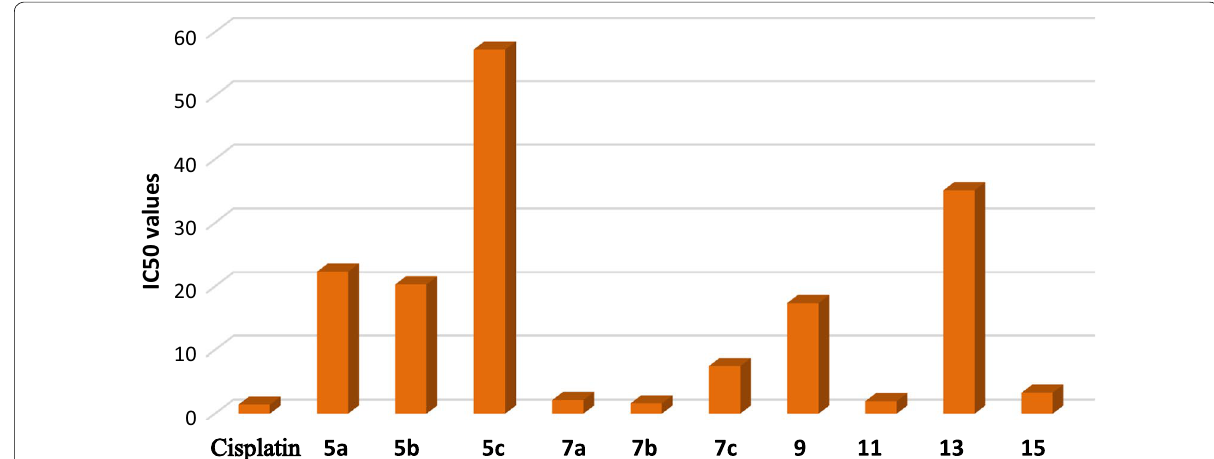
Fig. 3 Comparison of the IC 50 of the new synthesized compounds against Cisplatin